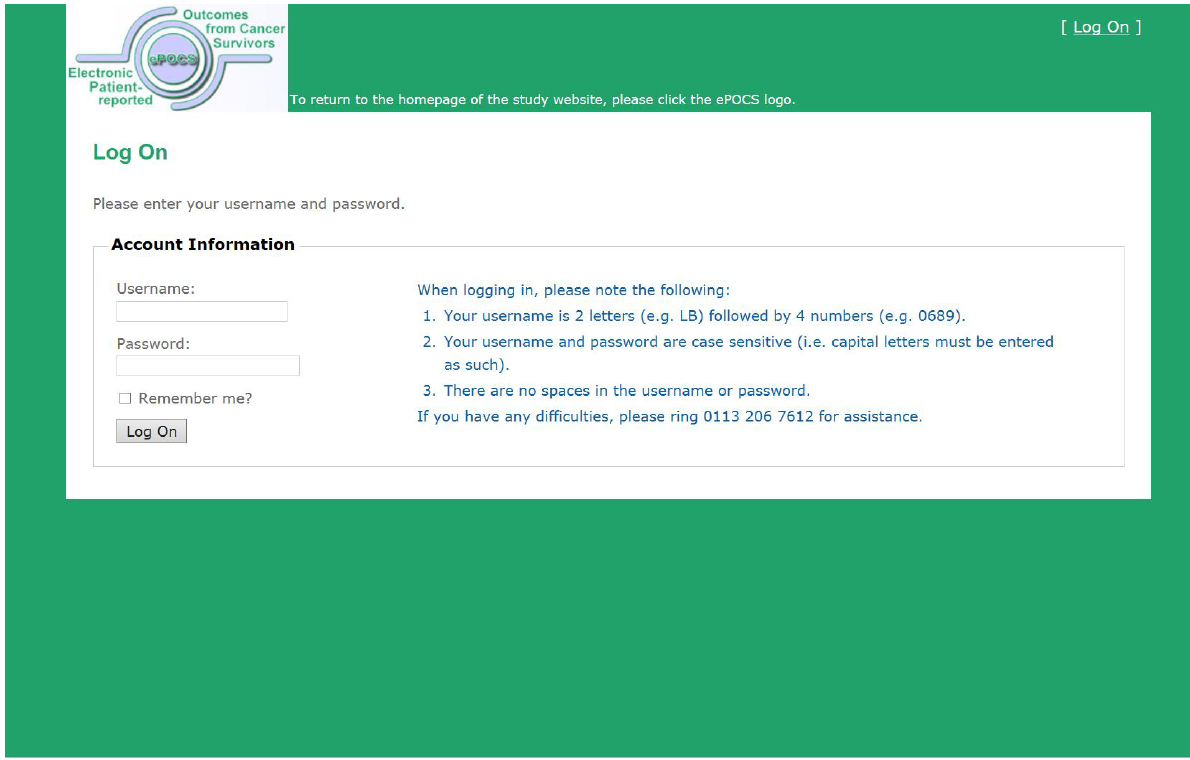
Figure 2. Screenshot of the login page of the ePOCS